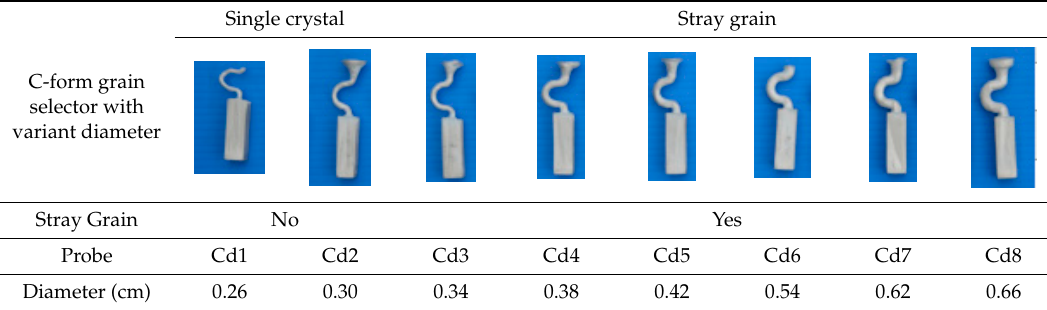
Table 2. Different pitch length parameters of C-form grain selectors: Group 2.